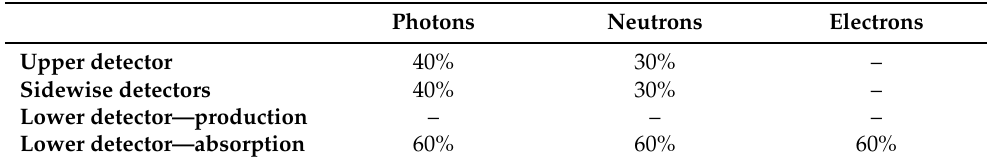
Table 5. The parameter set with the noise thresholds t min optimized for a lead block in water basin.